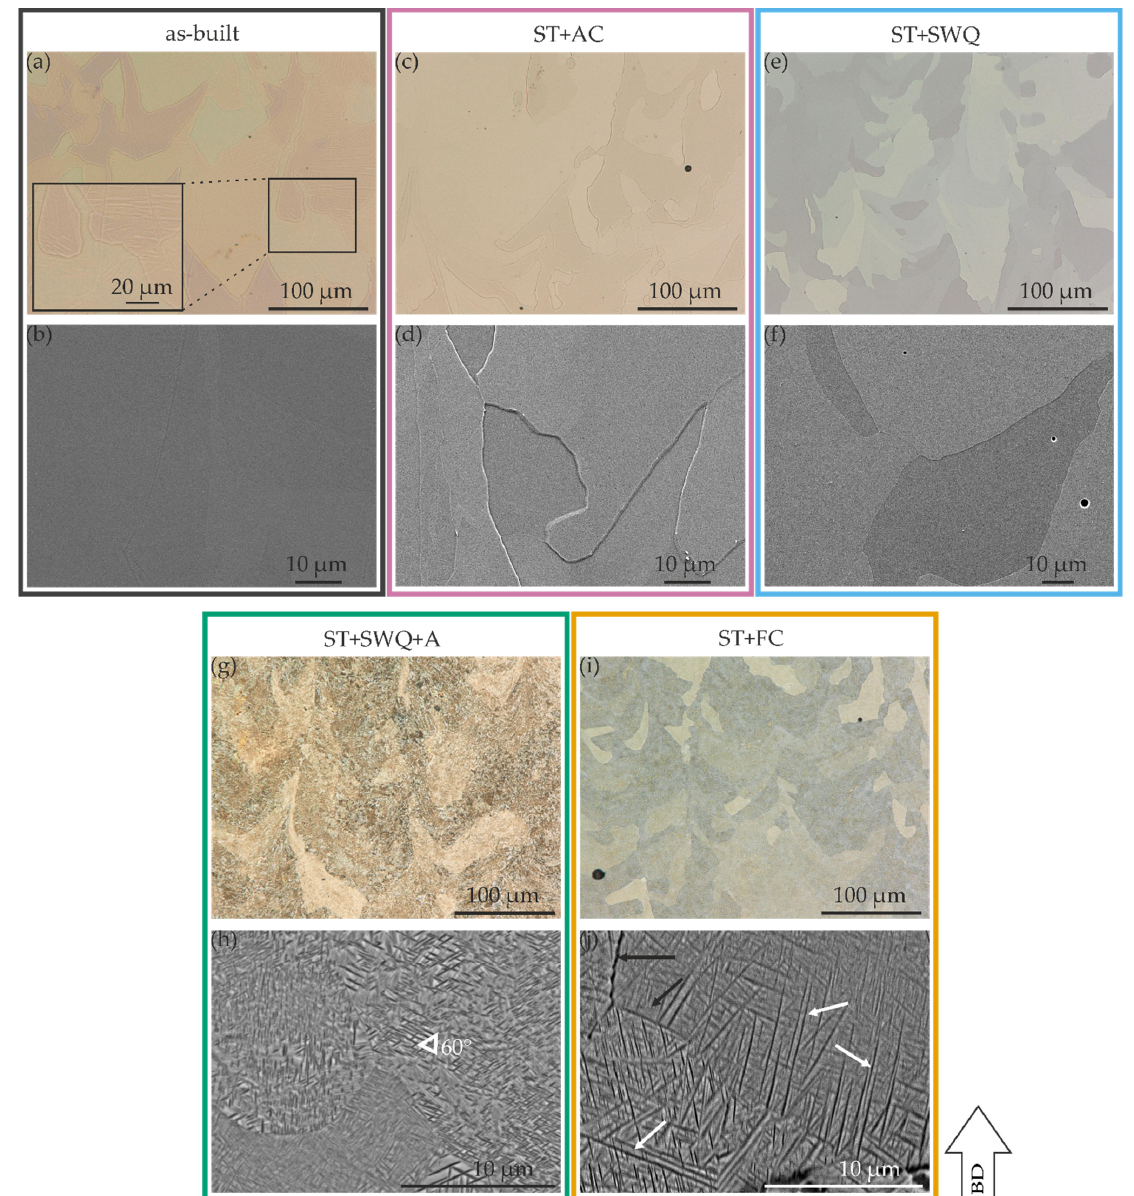
Figure 3. LiMi images of KOH-etched as-built ( a ) inset showing the black box in higher magnifica- tion), ST+AC ( c ), ST+SWQ ( e ), ST+SWQ+A ( g ), and ST+FC ( i ) conditions; and SEM images of KOH-etched as-built ( b ), ST+AC ( d ), ST+SWQ ( f ), ST+SWQ+A ( h ), and ST+FC ( j ) conditions; building di- rection (BD) for all conditions is indicated by the arrow.